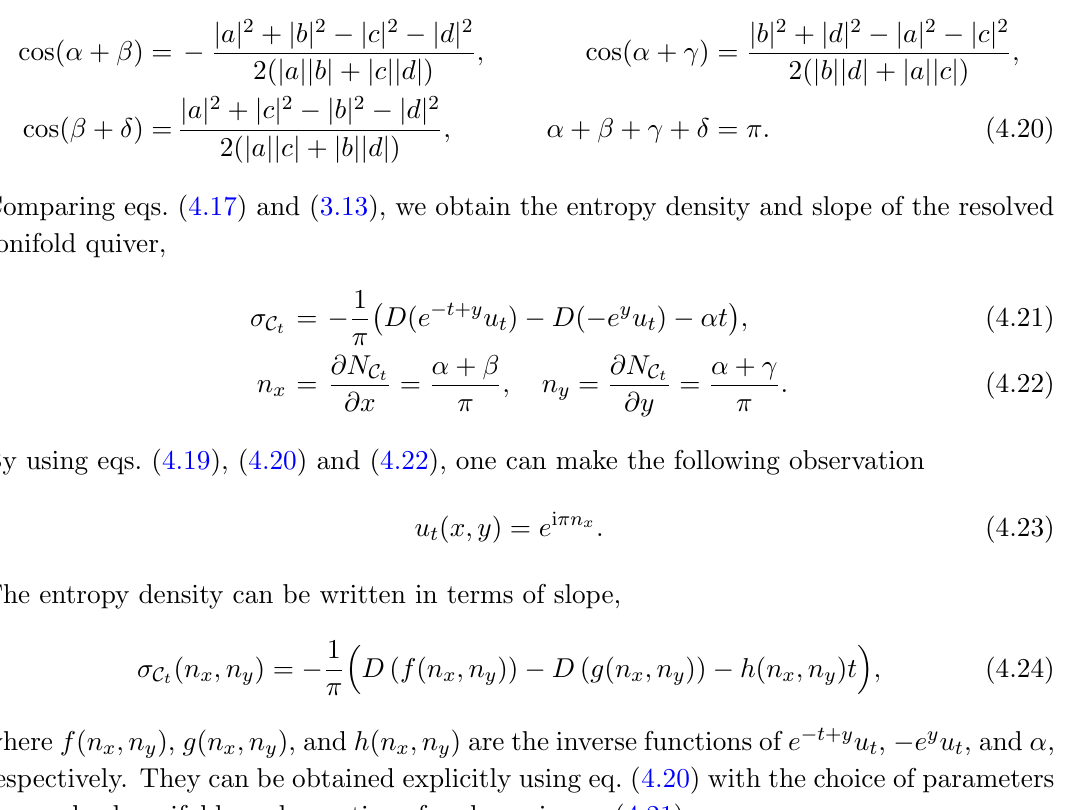
Figure 6 . Cyclic quadrilateral for resolved